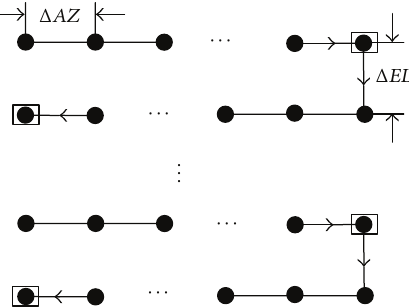
Figure 12: Sketch of scanning path for the scenario